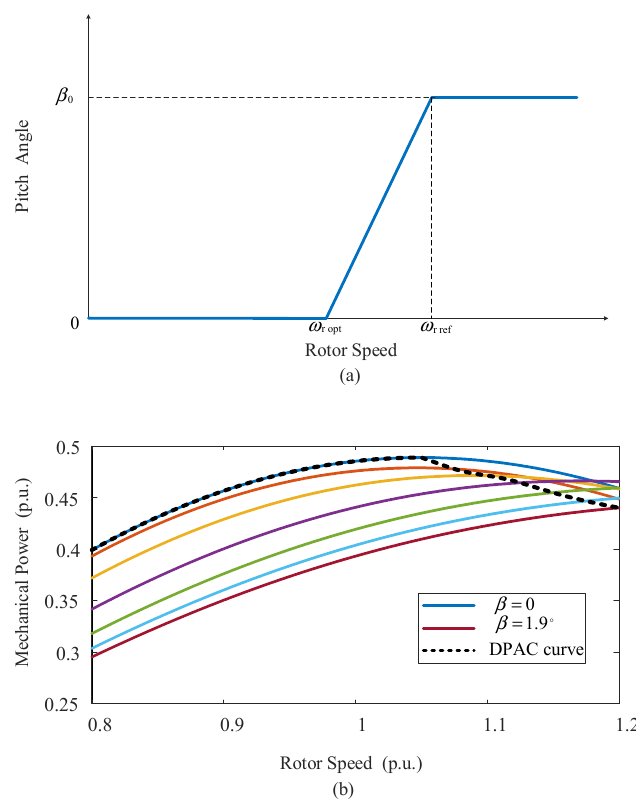
Figure 6. Configuration of DPAC.